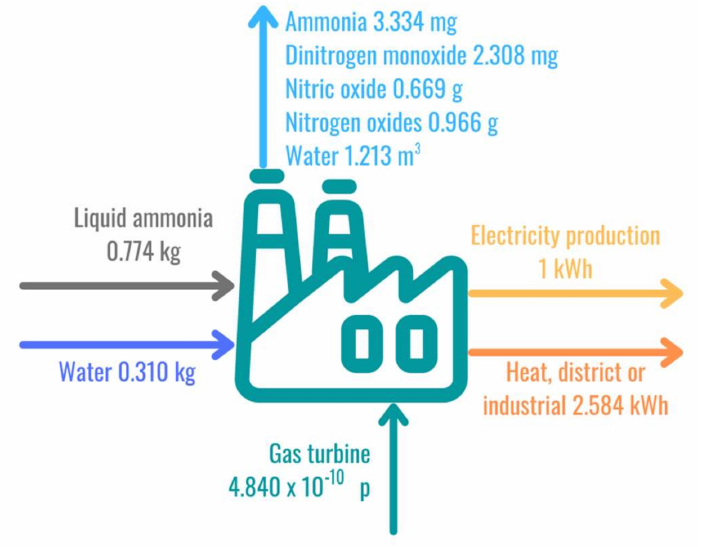
Figure 3. Materials and energy flows of the power cycle based on